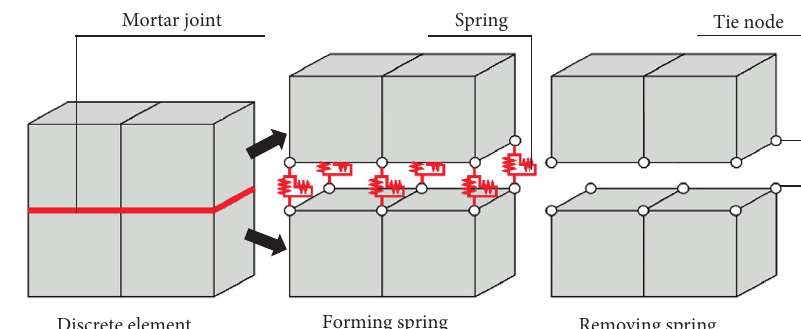
Figure 13: The diagrammatic sketch of whole failure process of infilled wall